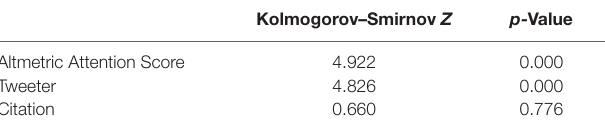
Table 5 | Two-sample Kolmogorov–smirnov test of two groups classified by whether first or corresponding author is in mainland china.